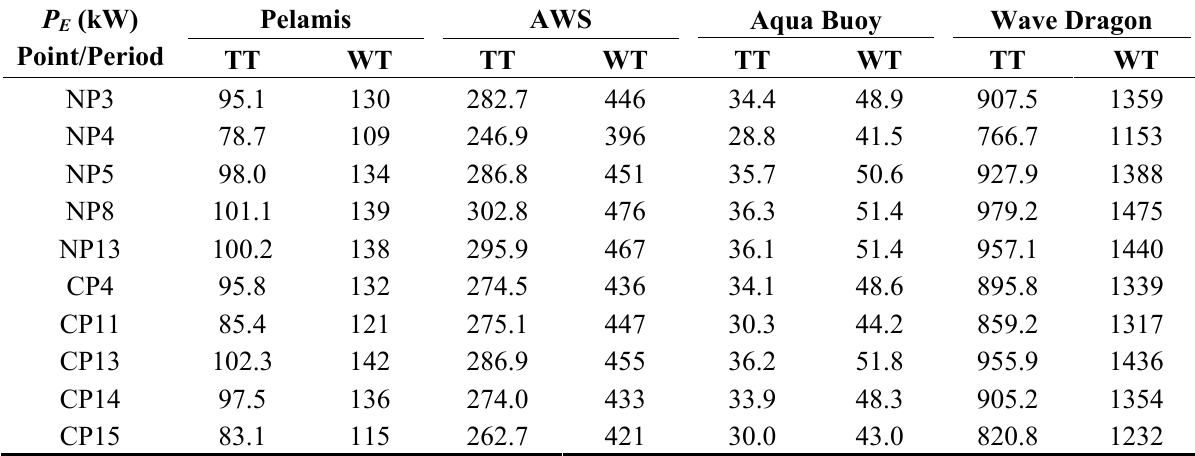
Table 5. Portuguese nearshore, average electric power in kW for ten most energetic reference points, estimations corresponding to the characteristics of four different WEC